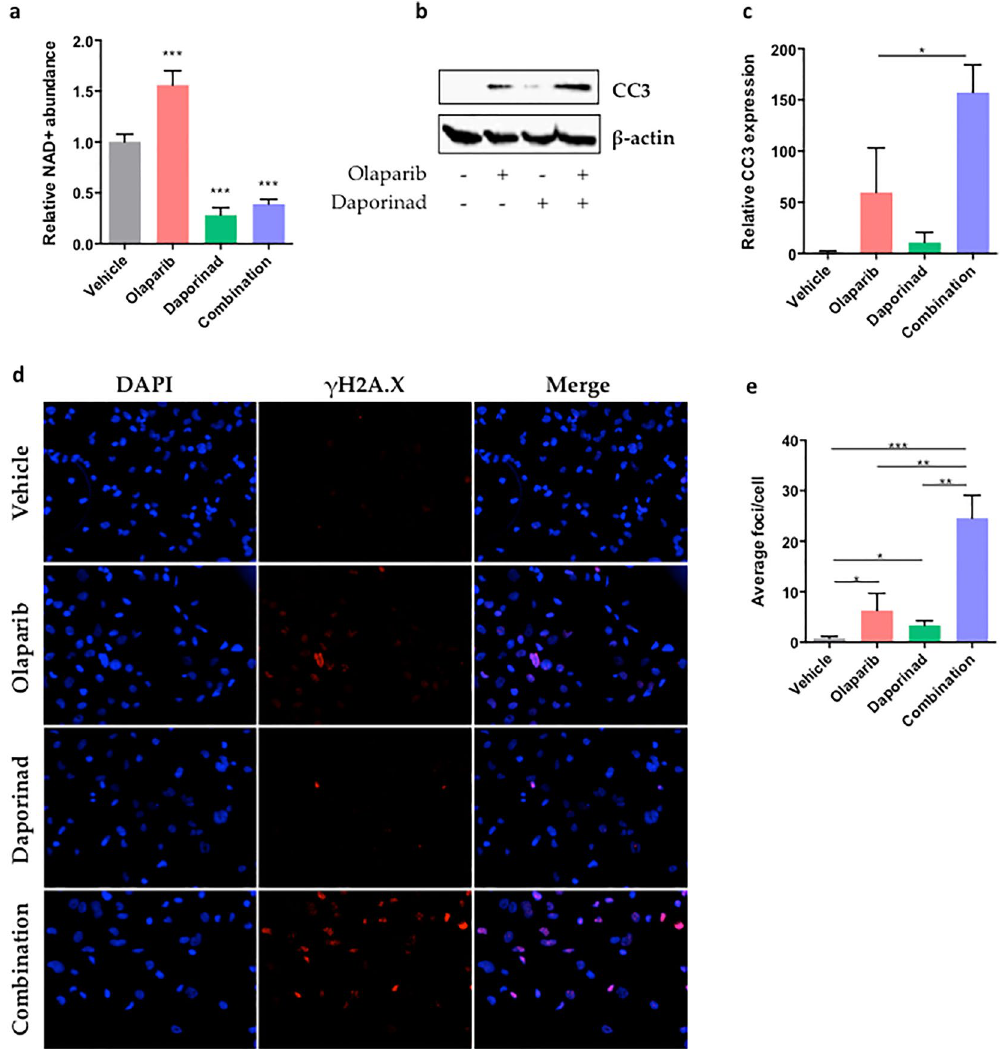
Figure 3. Effect of treatment on NAD+ metabolism and apoptosis. Relative intracellular NAD+ levels after 24 h of treatment ( a ). Western blot ( b ) and densitometry ( c ) of cleaved caspase-3 (CC3) expression after 5 days of treatment as a measure of apoptosis. Immunofluorescent staining ( d ) and quantification ( e ) of γH2A.X foci after 24 h of treatment as a measure of DNA damage. Experiments were repeated three times. Error bars represent SEM. Statistical significance was determined using Student’s t tests. *p < 0.05, **p < 0.01, ***p <